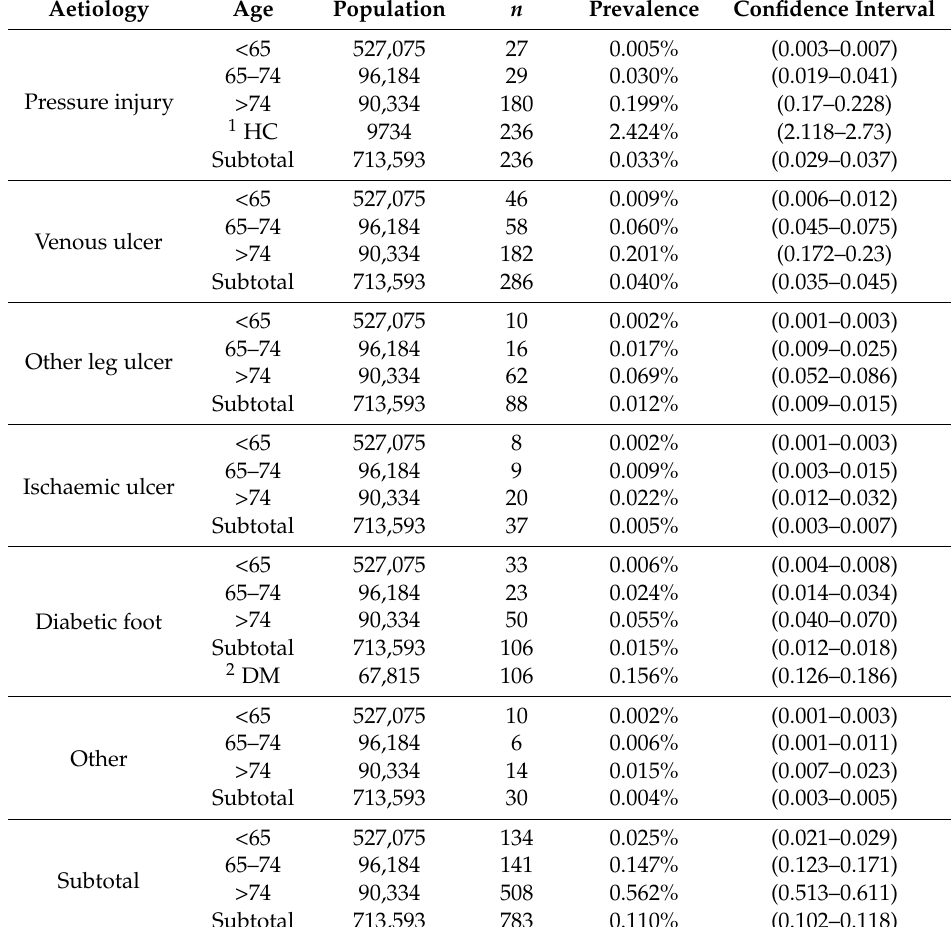
Table 2. Prevalence of chronic wounds.